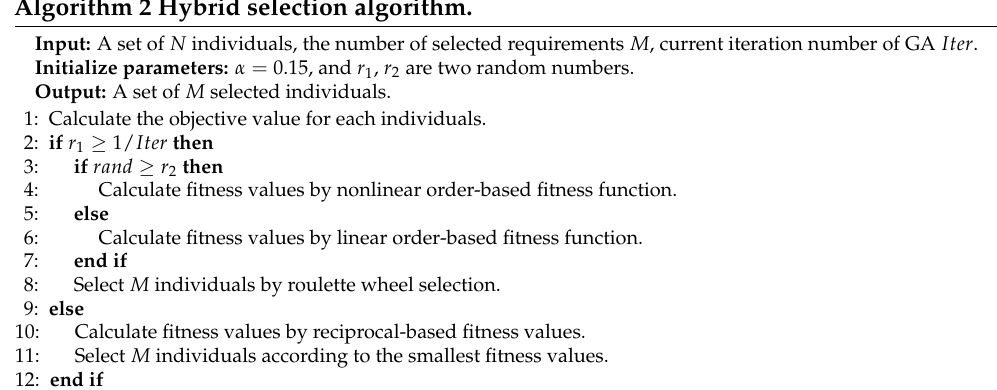
Algorithm 2 Hybrid selection